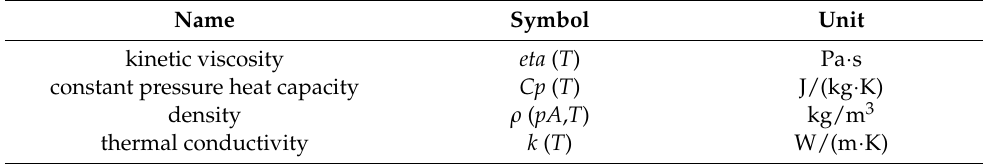
Table 4. Ambient domain